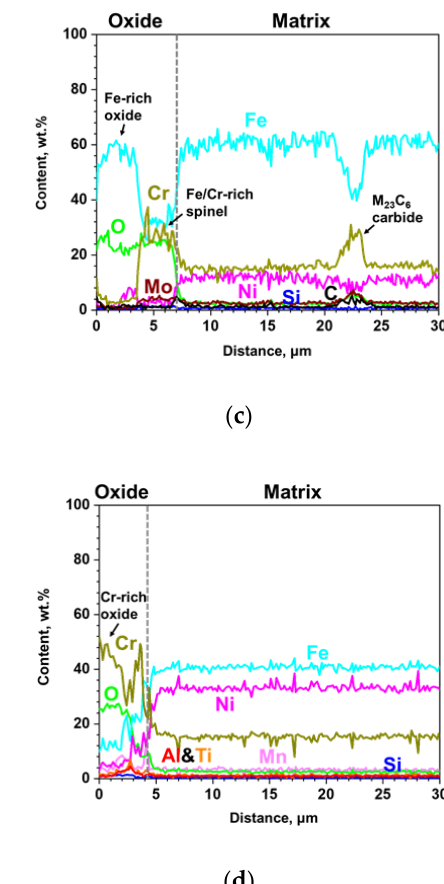
Figure 6. Room temperature tensile test results of ( a ) diffusion bonded SS 316H and ( b ) PBHT ‐ ed Alloy 800HT after S ‐ CO 2 exposure at 600 °C (20 MPa) for 1000 h.